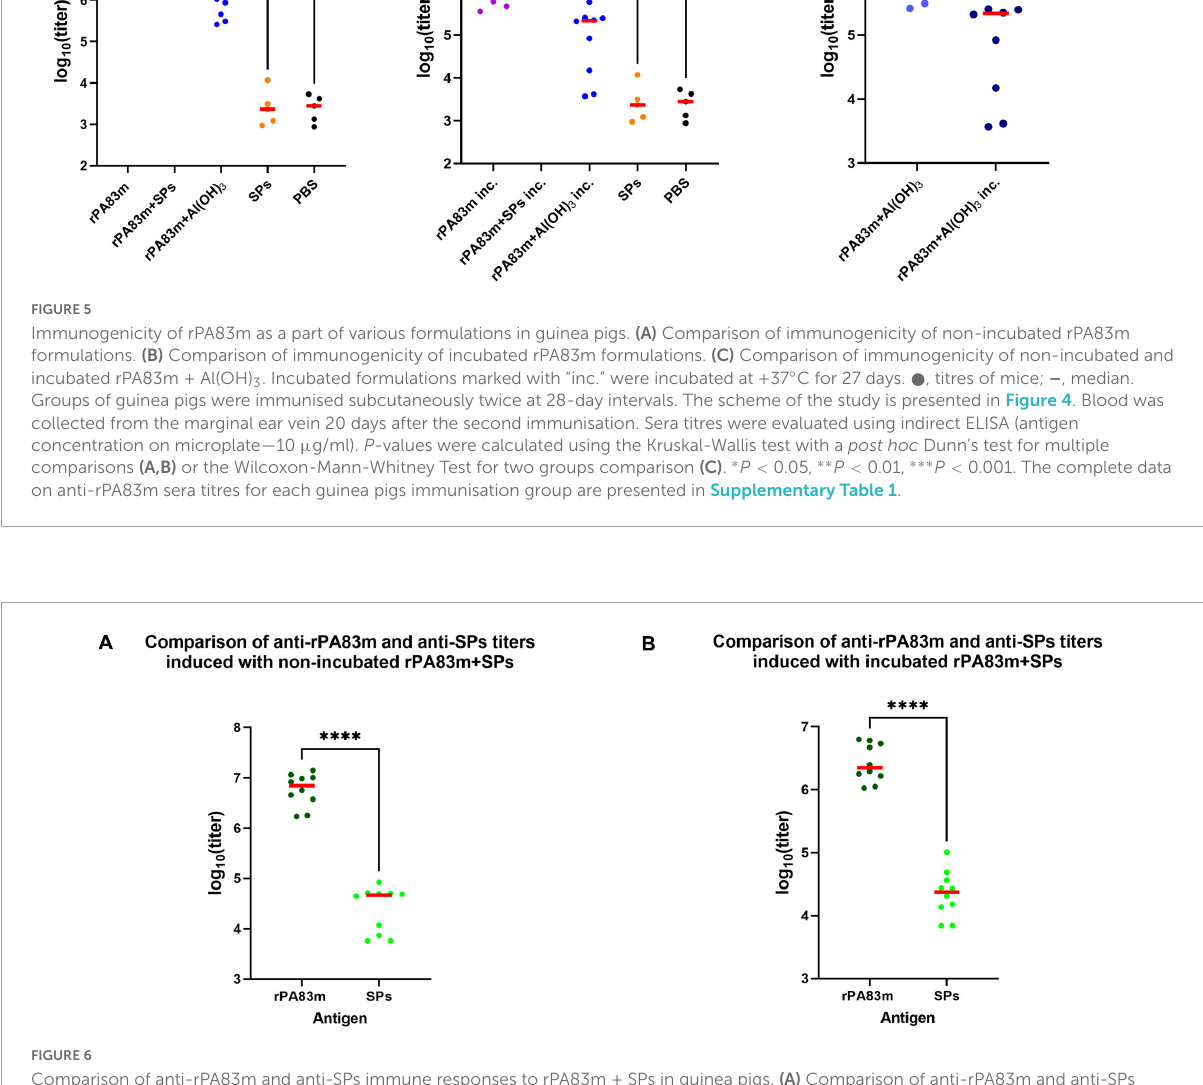
FIGURE6 Comparison of anti-rPA83m and anti-SPs immune responses to rPA83m + SPs in guinea pigs. (A) Comparison of anti-rPA83m and anti-SPs titres induced with non-incubated rPA83m + SPs. (B) Comparison of anti-rPA83m and anti-SPs titres induced with incubated rPA83m + SPs. Incubated formulations were incubated to +37 ◦ C for 27 days. , titres of mice; – , median. Groups of guinea pigs were immunised subcutaneously twice at 28-day intervals. The scheme of the study is presented in Figure 4 . Blood was collected from the marginal ear vein (cid:32) 20 days after the second immunisation. Sera titres were evaluated using indirect ELISA (antigen concentration on microplate—10 µ g/ml). P -values were calculated using the Wilcoxon-Mann-Whitney Test. ∗∗∗∗ P < 0.0001. The complete data on anti-SPs sera titres for corresponding guinea pig immunisation groups are presented in Supplementary Table 2